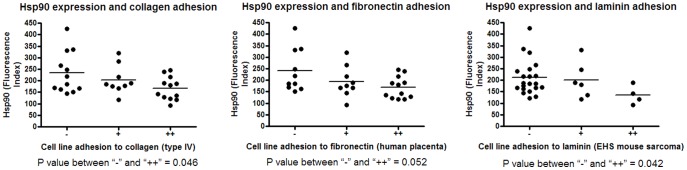
Correlation between Hsp90 expression and cell line ligand adhesion.Hsp expression was tested for correlation with the adhesion ability of these cell lines to the collagen type IV, fibronectin and laminin ligands.